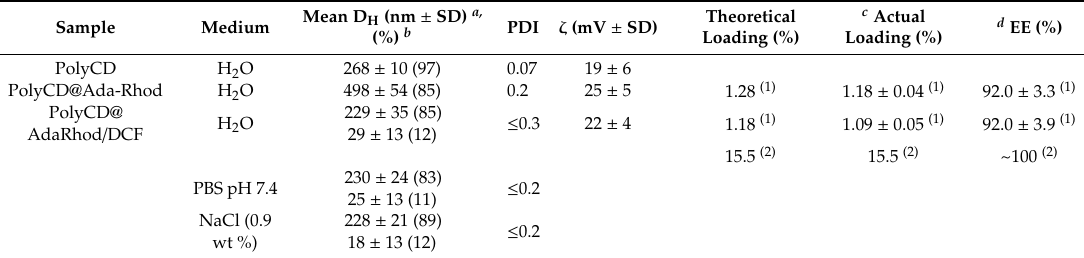
Table 1. Overall properties of PolyCD-based nanoassemblies: mean D H , polidispersity index (PDI) and ζ -potential values ( ζ ), loading and EE% in ultrapure water.